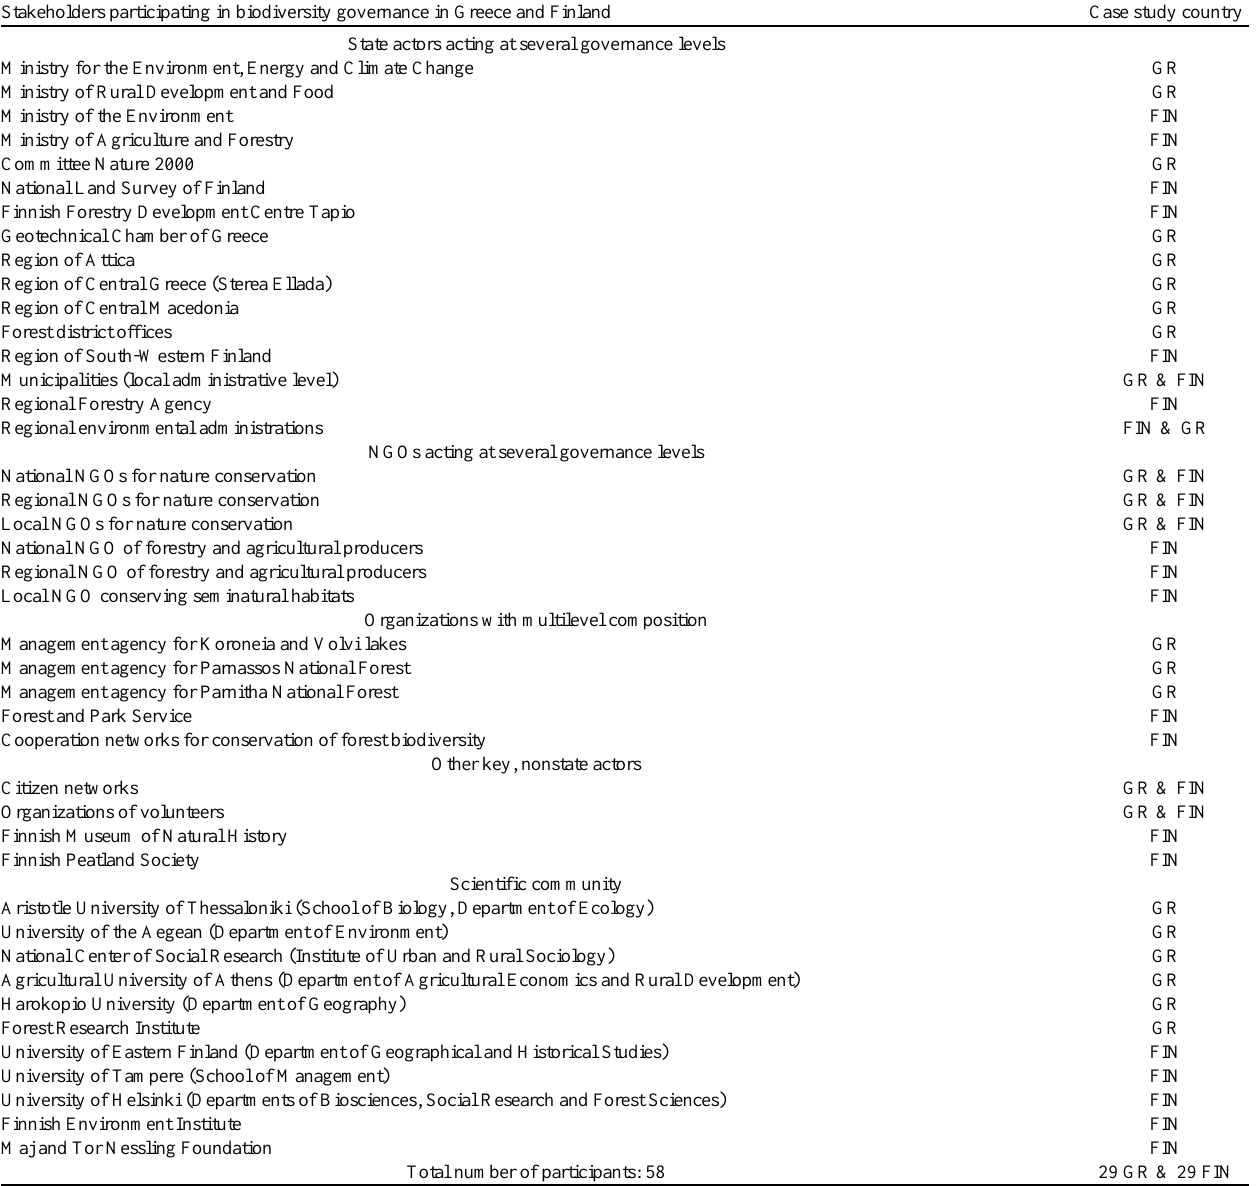
Table 1 . Research participants in the focus group discussions in Finland and